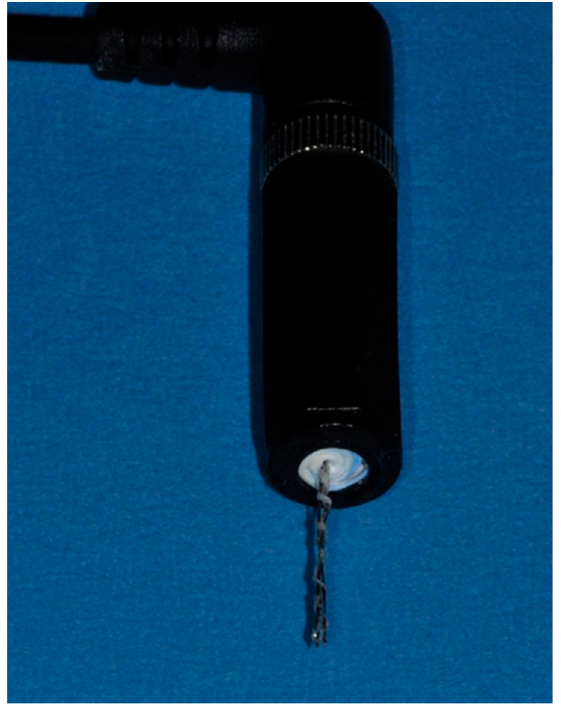
Figure 2. Disinfection apparatus consisting of an electrode array with intermediate insulating material.